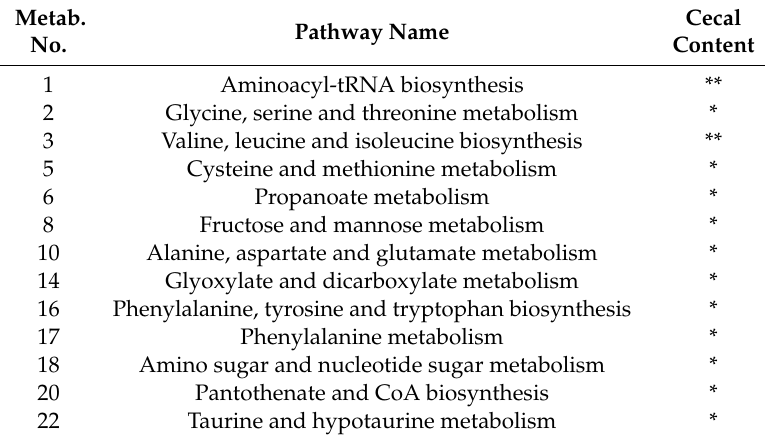
Table 8. Potential metabolic pathways linked to taurine intake in cecal content.